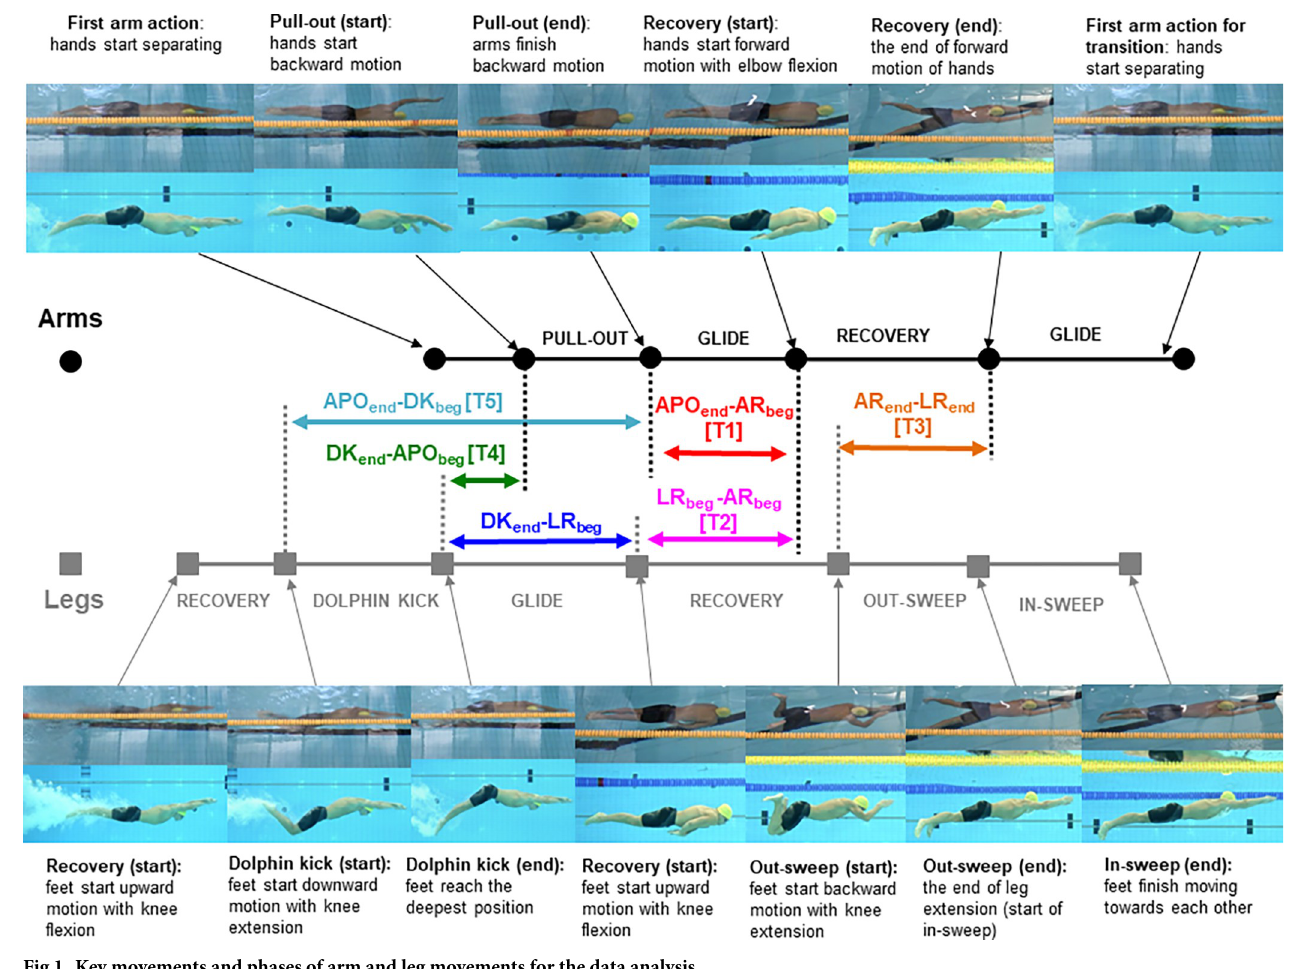
Fig 1. Key movements and phases of arm and leg movements for the data analysis.